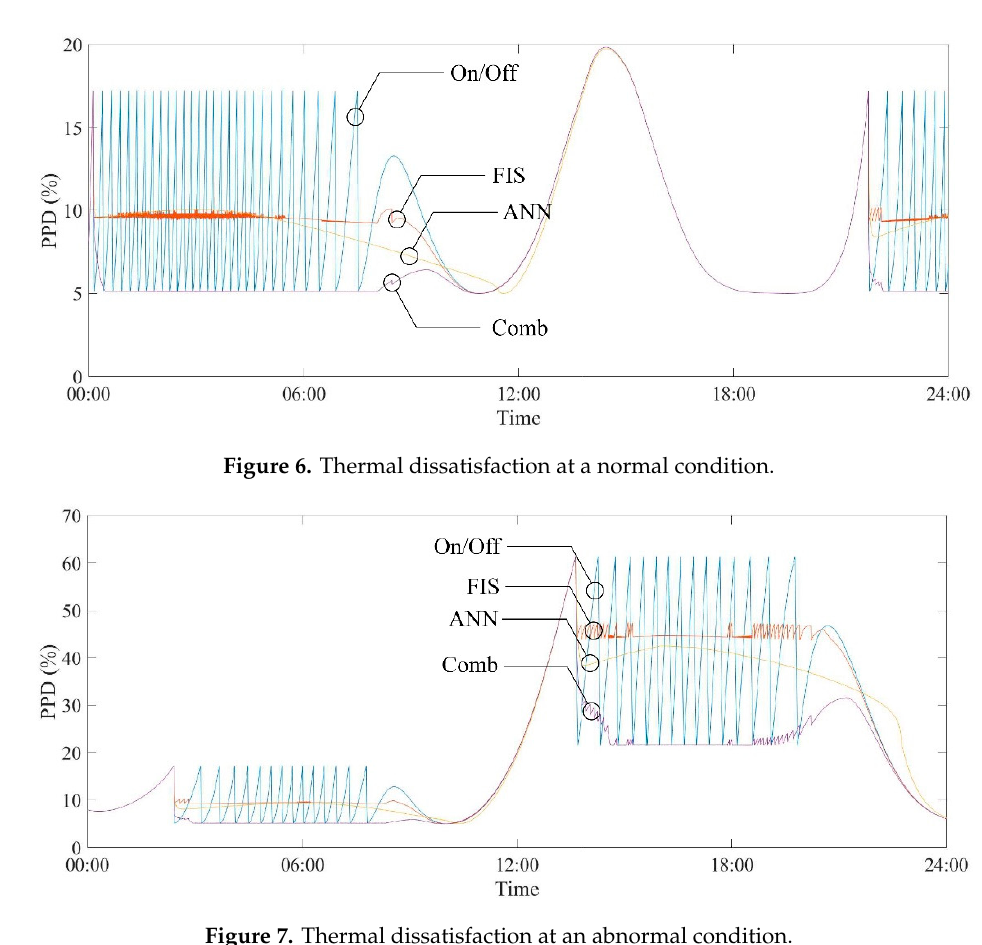
Figure 7. Thermal dissatisfaction at an abnormal condition.